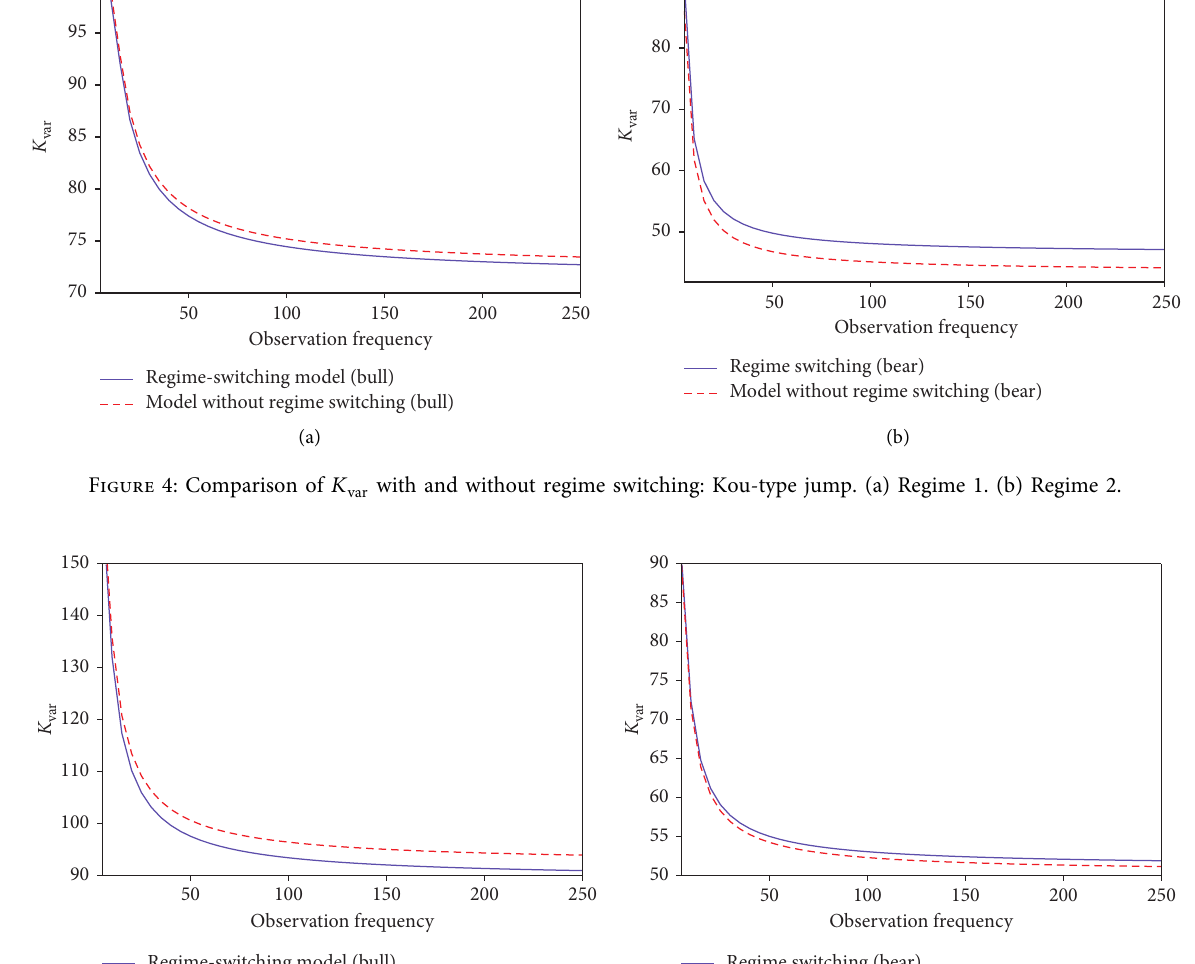
. (a) Regime 1. (b) Regime 2. 2